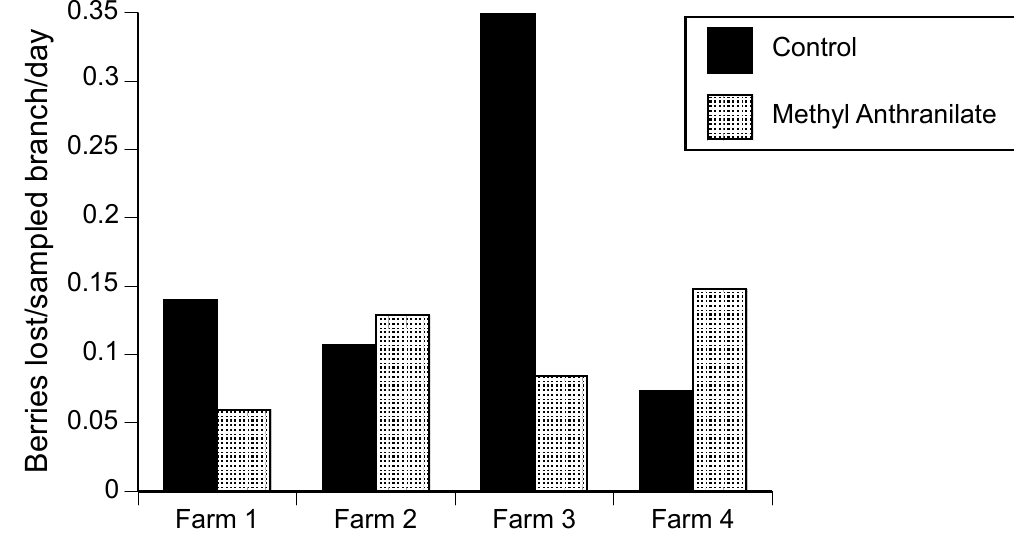
Figure 4. Blueberries per sampled branch per day lost to birds in control halves of fields compared to halves of fields treated with Avian Control ® in 2015.